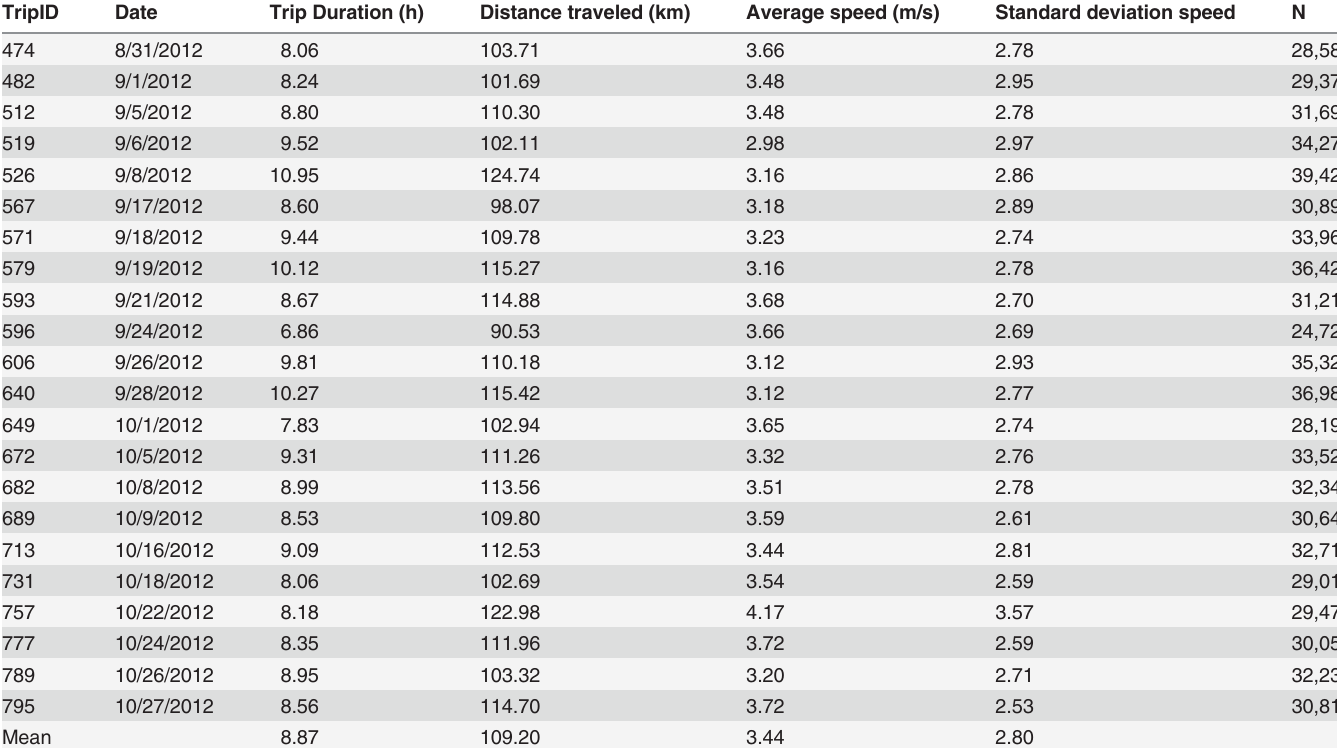
Table 1. Parameters for individual foraging trips by Dominican FAD fi shers.